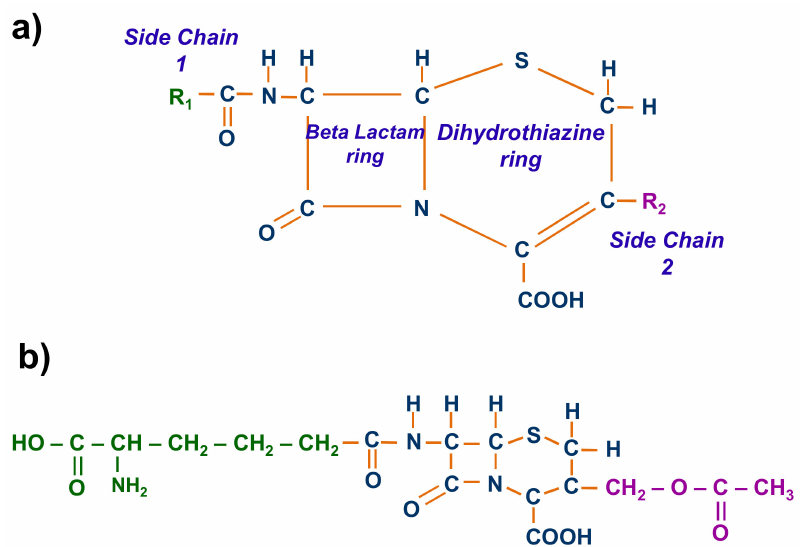
Figure 2. ( a ) General chemical structure of cephalosporins; ( b ) chemical structure of cephalosporin